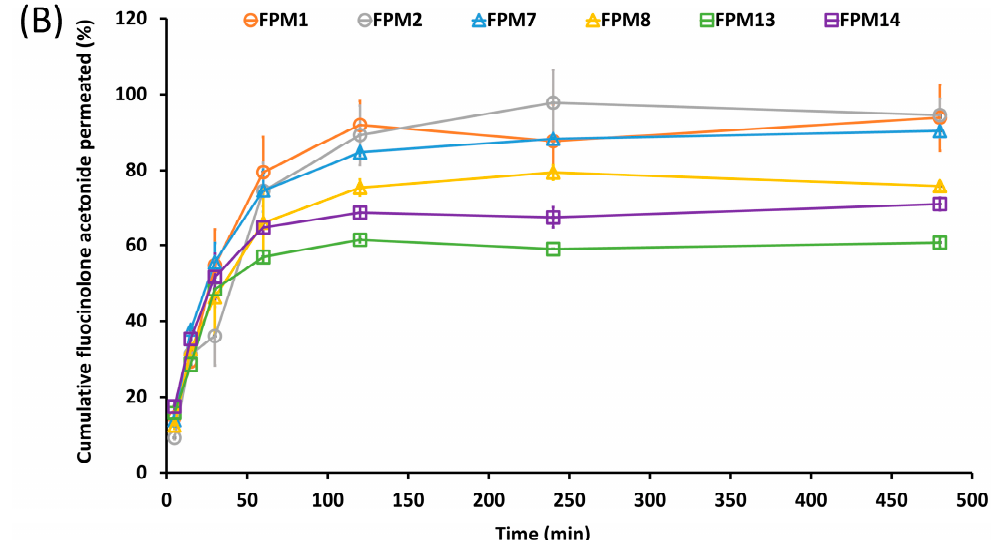
Figure 3. Percentage of fluocinolone acetonide (FA) release ( A ) and percentage of fluocinolone acetonide (FA) permeation ( B ) of all FPMs formulation.